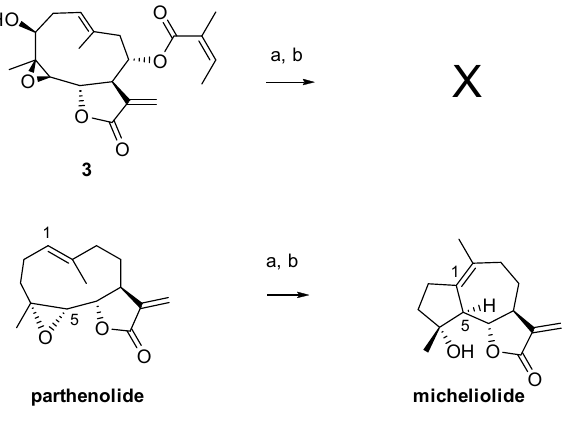
Figure 2 Energy profile of the putative transannular cyclization of 3 . Relative energies are reported in Scheme 5. Reactivity of 3 and parthenolide with acids. Scheme 5. Reactivity of 3 and parthenolide with acids. kcal/mol. The hydrogen bonding interaction O-3…H-6 is represented with a dashed line.